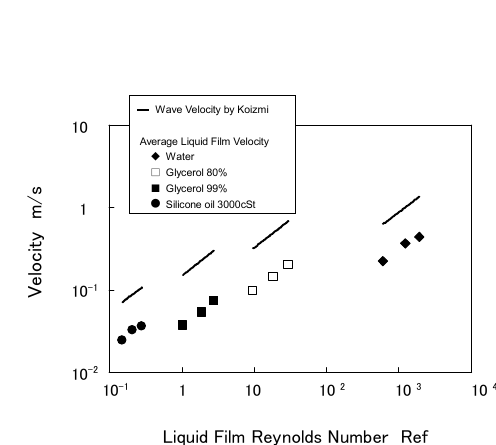
Fig.10 Average velocity of liquid film u 0 and wave velocity u w by